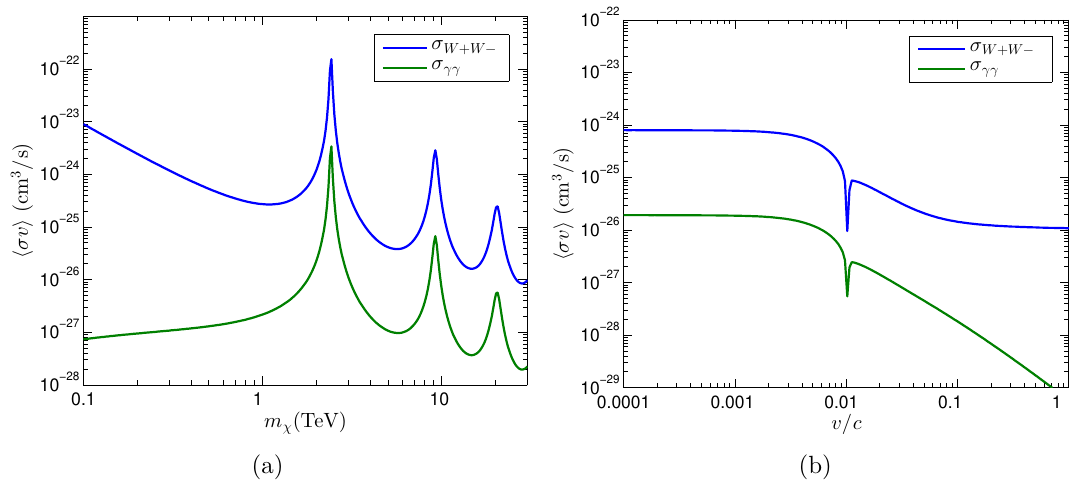
Figure 16. Annihilation cross-section of χ 0 χ 0 state into independent modes W + W − (blue) and γγ (red) in real triplet model, as function of mass at v = 10 − 3 c (16(a)), and of DM velocity at m 0 = 2 . 85 TeV